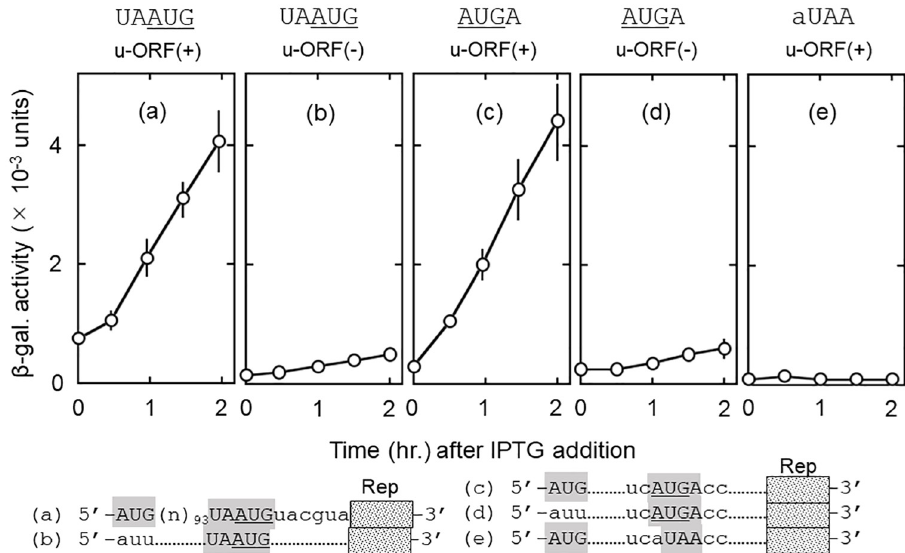
Fig 2. Downstream reading of translationally coupled ORFs is dependent on the presence of u-ORF and the initiation triplet of d-ORF. E . coli LJ14 cells harboring plasmids were grown at 28˚C to a cell density of ~0.13 as described in Experimental procedures and IPTG (final 2 mM) was added to the culture for induction of the reporter lacZ ( Δ 27) gene. The culture was incubated for another two hours. At the indicated times after the addition of IPTG, an aliquot was taken and the β -galactosidase activity was measured. The junction sequences and presence (+) or absence ( − ) of u-ORF are shown above each panel. The nucleotide sequences around the junction sequence are shown at the bottom. Rep represents the reporter lacZ ( Δ 27) gene. Dotted lines ( ...... ) in (b) through (e) represent the same nucleotide sequences with that of (a) in the corresponding regions. Panels (a) and (c) represent the β -galactosidase synthesis through translational coupling. (b) and (d) are identical to (a) and (c), respectively, with the exception that AUG of u-ORF was changed to auu. (e) is identical with (c) with the exception that (e) has aUAA instead of AUGA. The reporter lacZ gene is in frame with AUG of UAAUG, AUGA and aUA of